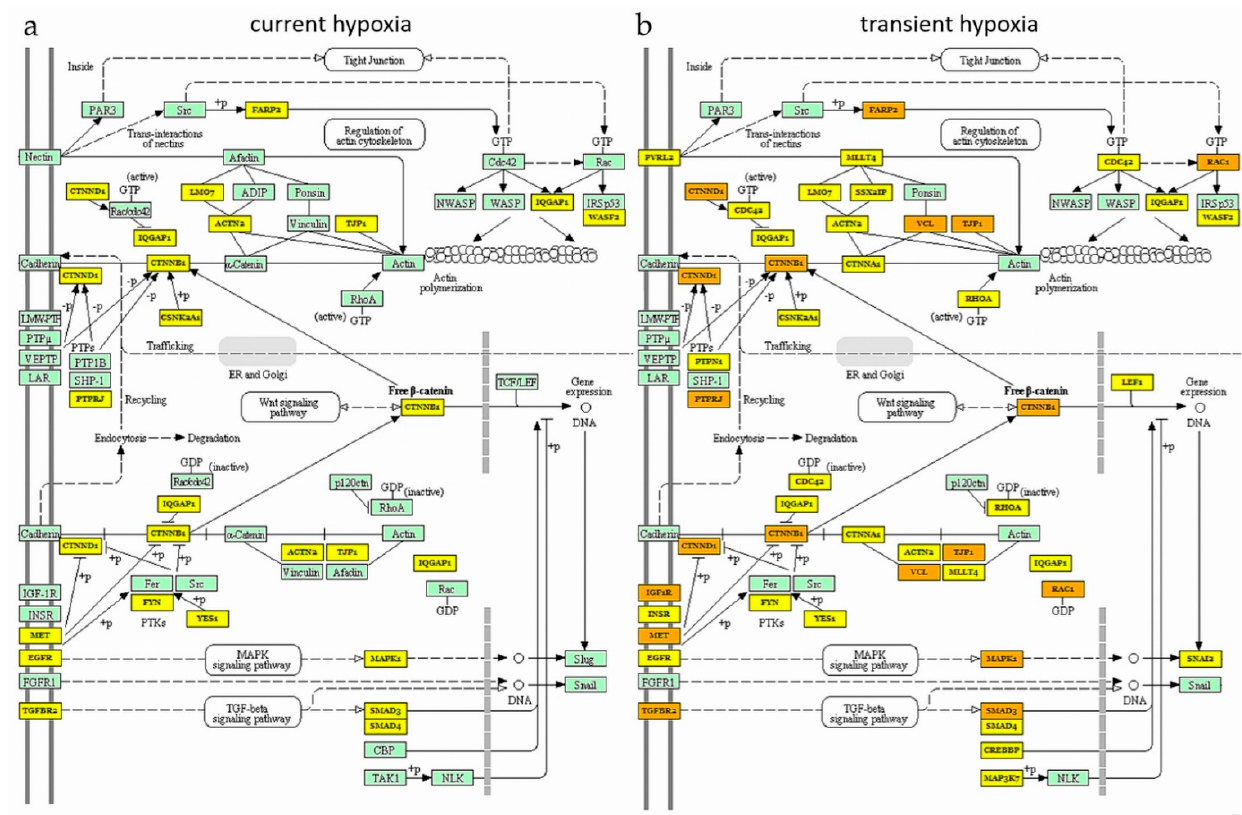
Figure 4. AngiomiR target mRNAs within the KEGG pathway ‘adherens junction’. This pathway was identified to be altered after transient hypoxia (HONO), but not by current hypoxia (HO). ( a ) indicates the target genes of angiomiRs altered (significantly or by trend) under current hypoxia (HO). ( b ) indicates the target genes of angiomiRs altered (significantly or by trend) under transient hypoxia (HONO). Yellow coloring of genes indicates that mRNAs are targeted by one miRNA, orange coloring of genes indicates mRNAs targeted by several miRNAs. KEGG pathways were generated using DIANA mirPath software.